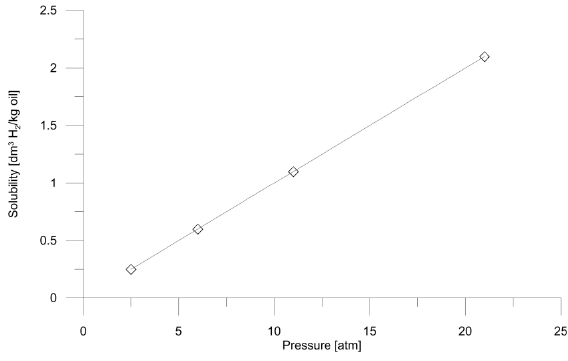
Figure 2. Relationship between pressure and hydrogen solubility (180 °C).